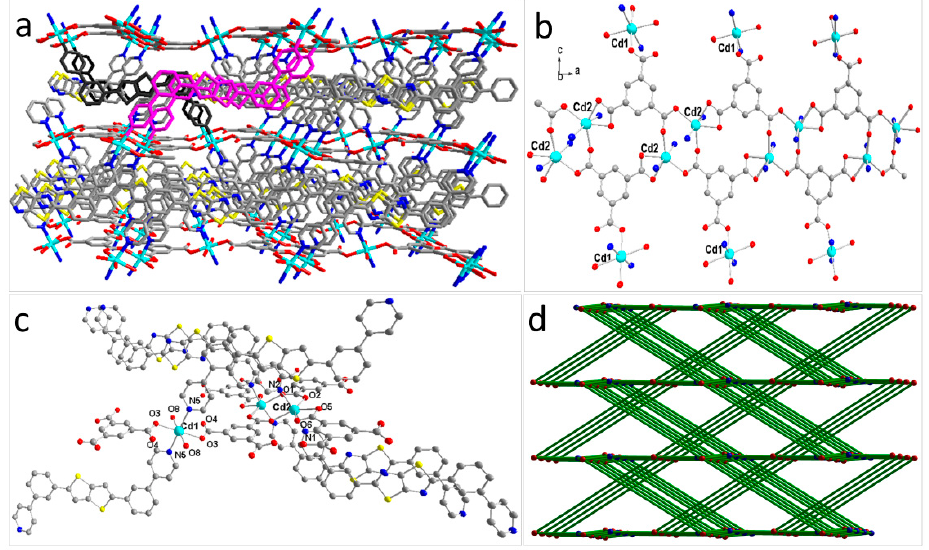
Figure 3. The 3D network of 3 ( a ), the 2D [Cd(BTC)] n layer in 3 ( b ), the coordination environment of Cd(II) in 3 ( c ), and the topological network formed in 3 ( d ); red spheres represent Cd(II) centers, blue spheres represent the benzene-1,3,5-tricarboxylic acid (BTC - ) ligands.